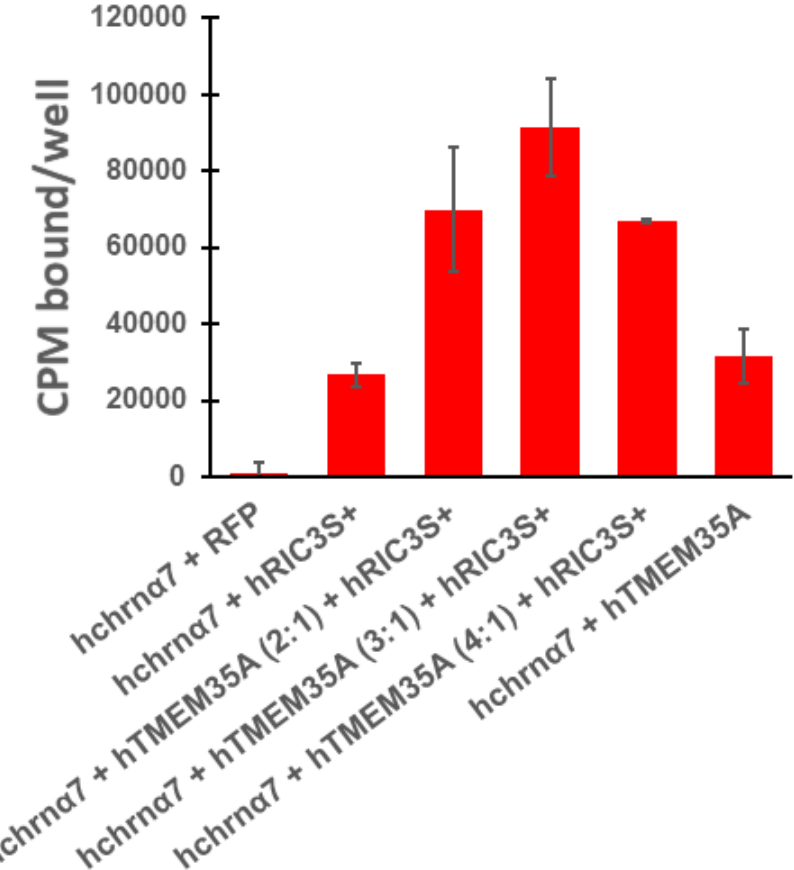
Figure 6. The absence of NACHO in HEK cells has no e ff ect on the ability of RIC3 to promote surface human α 7nAChR expression, and the e ff ects of the two chaperones are synergistic when expressed together. Binding assays in 24-well plates were performed as indicated in methods. Total cDNA in transfections was constant, with hchrna7 DNA (0.15 µ g / well) that was equaled the sum of htmem35a and hric3 cDNA or RFP DNA (0.15 µ g / well RFP DNA in transfection controls). The ratio of 3 parts htmem35a cDNA to 1 part hric3 cDNA (e.g., 0.11 µ g htmem35a and 0.04 µ g hric3 / well) produced the highest surface α 7nAChR expression in HEK cells. In all 4 experiments, the combined e ff ects were more than additive. In experiments where RIC3 or NACHO was the only chaperone, surface α 7nAChR expression was comparable between these two chaperones as shown.